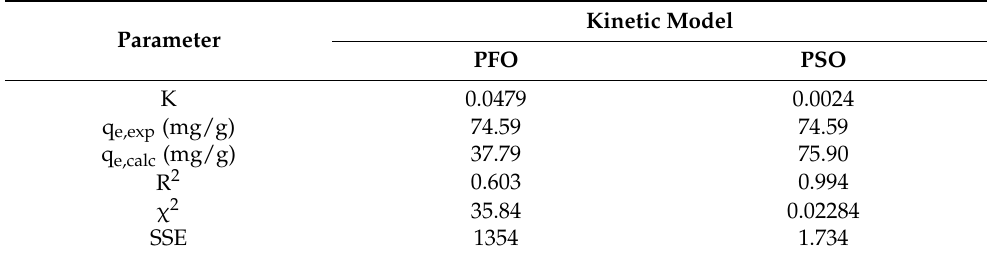
Table 1. Different kinetic models’ parameters for DV31 removal from an aqueous solution by G CuO